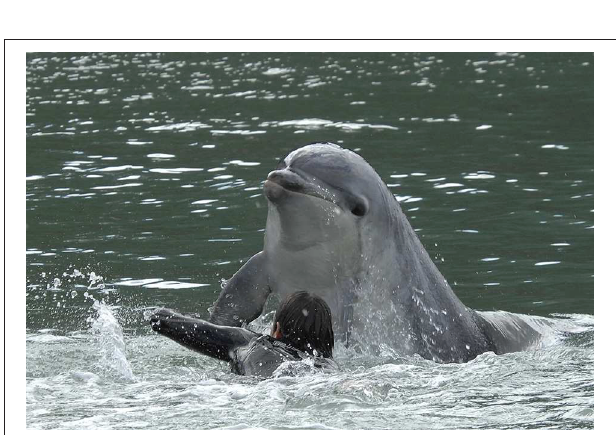
FIGURE 6 | “Moko” being pursued by a swimmer in Whakatane, New Zealand (Photo: Ingrid